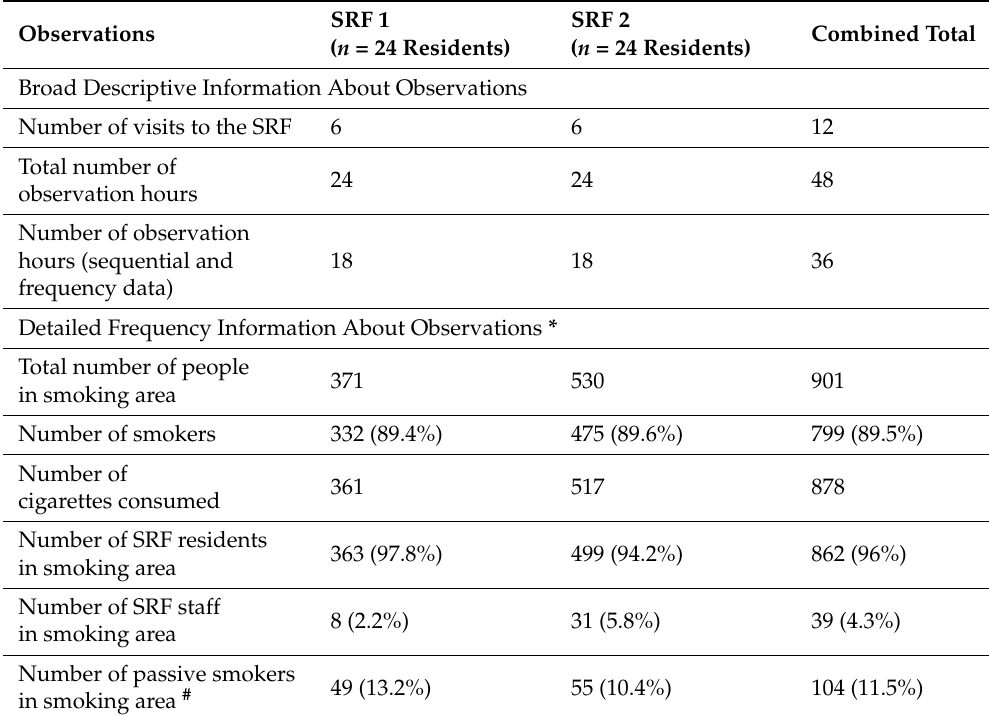
Table 1. Summary of observations from the supported residential facilities’ smoking